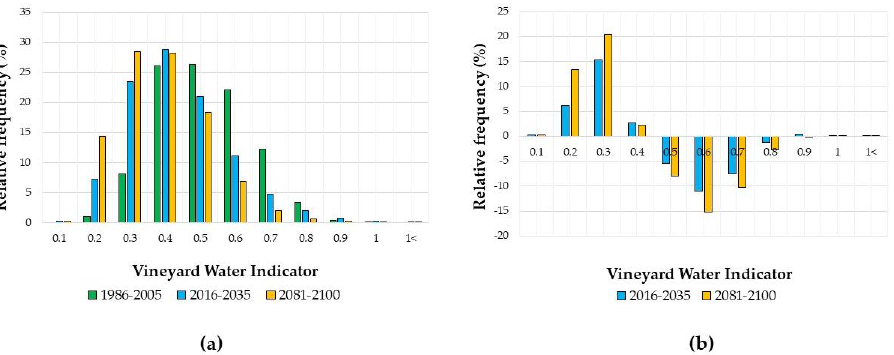
Figure 7. Frequency distribution of the Vineyard Water Indicator (VWI) in Hungary during the growing season in the three investigated periods ( a ) and changes of these frequencies from the 1986 – 2005 reference period to the near (2016 – 2035) and distant (2081 – 2100) future periods ( b ).